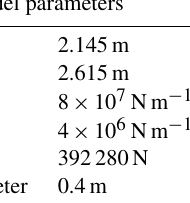
Figure 1. Analytic model for single-main-bearing set-up in one plane. The full model consists of two such representations, one in each of the horizontal and vertical planes (Hart et al., 2019).